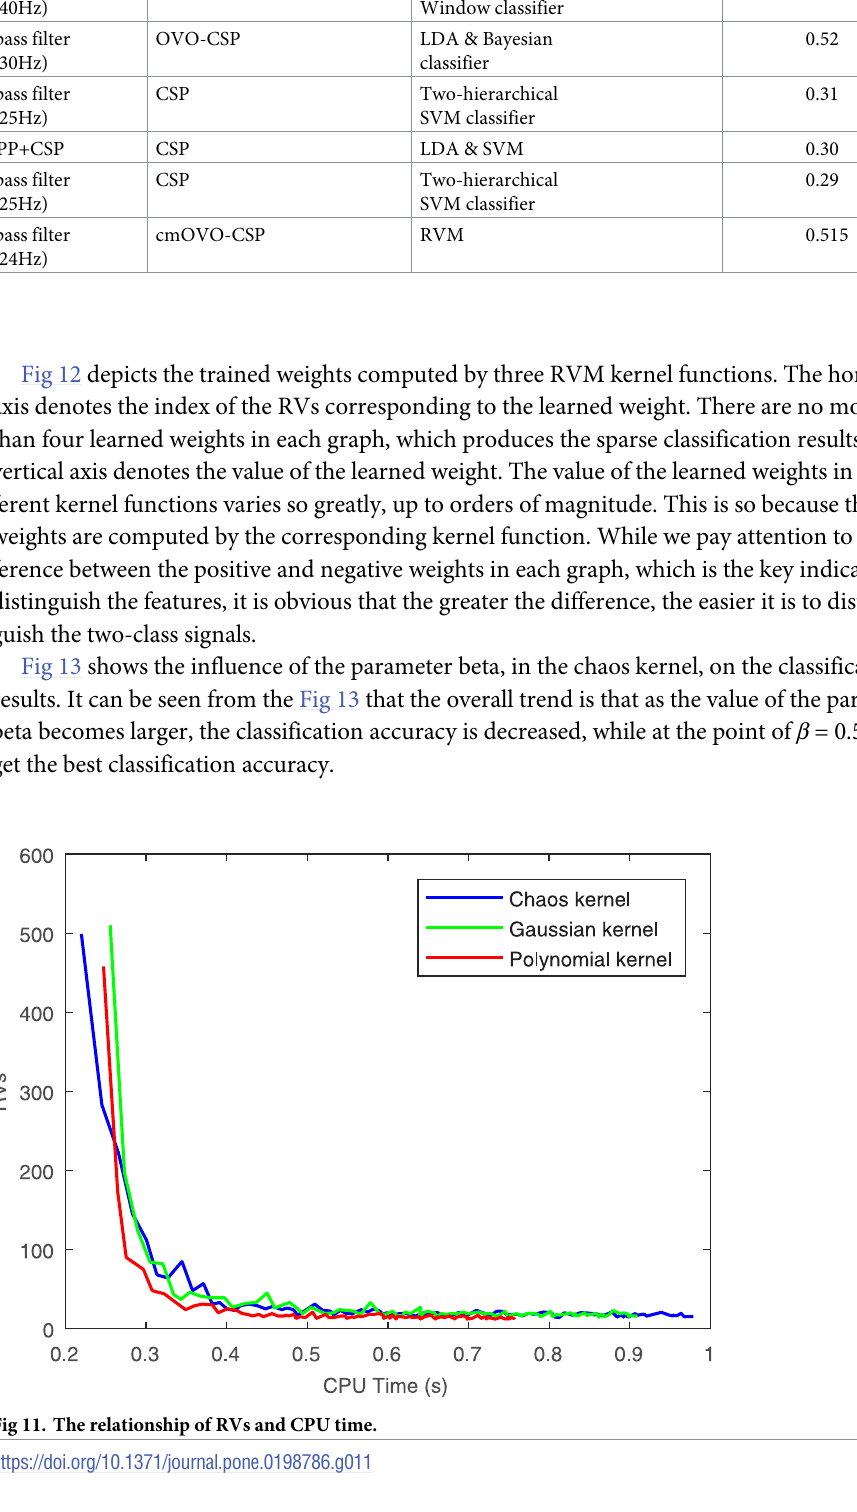
Table 4. Comparison of the proposed method and the competition methods.